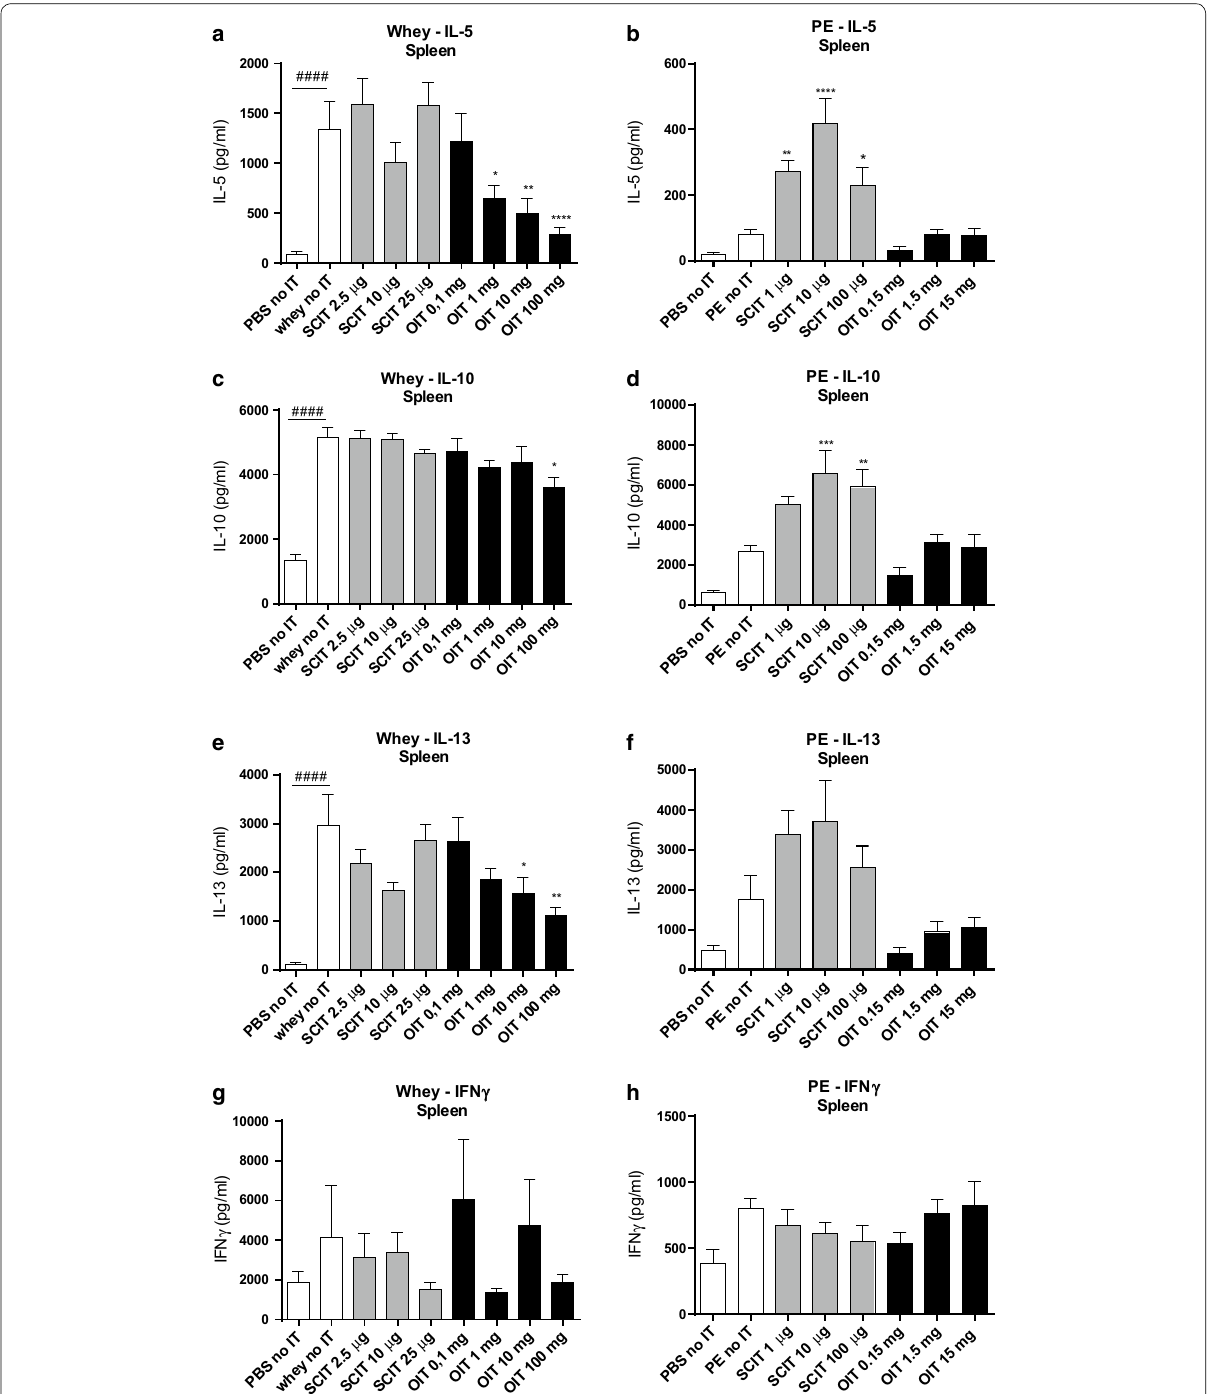
Fig. 5 Cytokine concentrations after ex vivo stimulation of splenocytes with whey or PE determined by ELISA. Splenocytes were cultured for 96 h in the presence of PE, whey or medium (medium data not shown). a , b IL-5 concentration. c , d IL-10 concentration. e , f IL-13 concentration. g , h IFNγ concentration. Data are represented as mean SEM n 6/8 mice/group. Statistical analysis was performed using one-way ANOVA and Dunnett’s ± = post hoc test for multiple comparisons. # P < 0.05; ## P < 0.01; ### P < 0.001; #### P < 0.0001 compared to sham-sensitized control. *P < 0.05; **P < 0.01; ***P < 0.001; ****P < 0.0001 compared to whey- or PE-sensitized control. PE peanut extract, OIT oral immunotherapy, SCIT subcutaneous immuno- therapy, IT